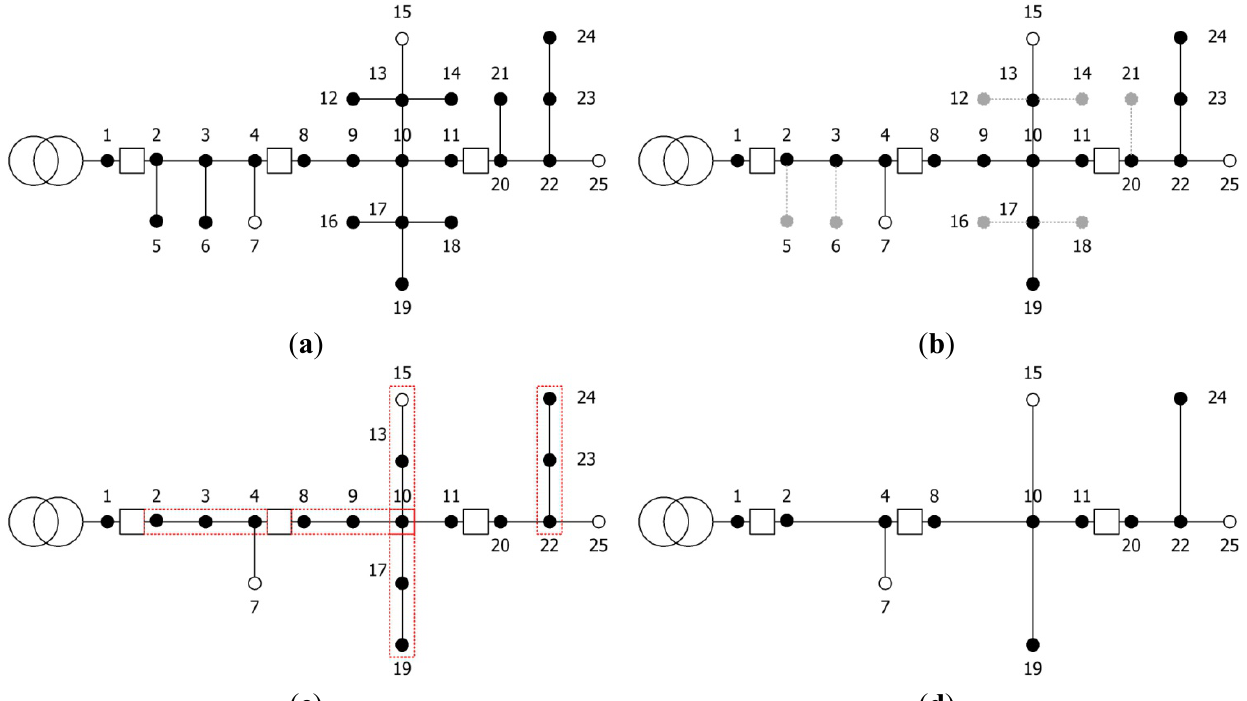
Figure 8. Network reduction procedures: ( a ) initial network topology; ( b ) simple diverged branches removal; ( c ) successive branches integration; ( d ) after network